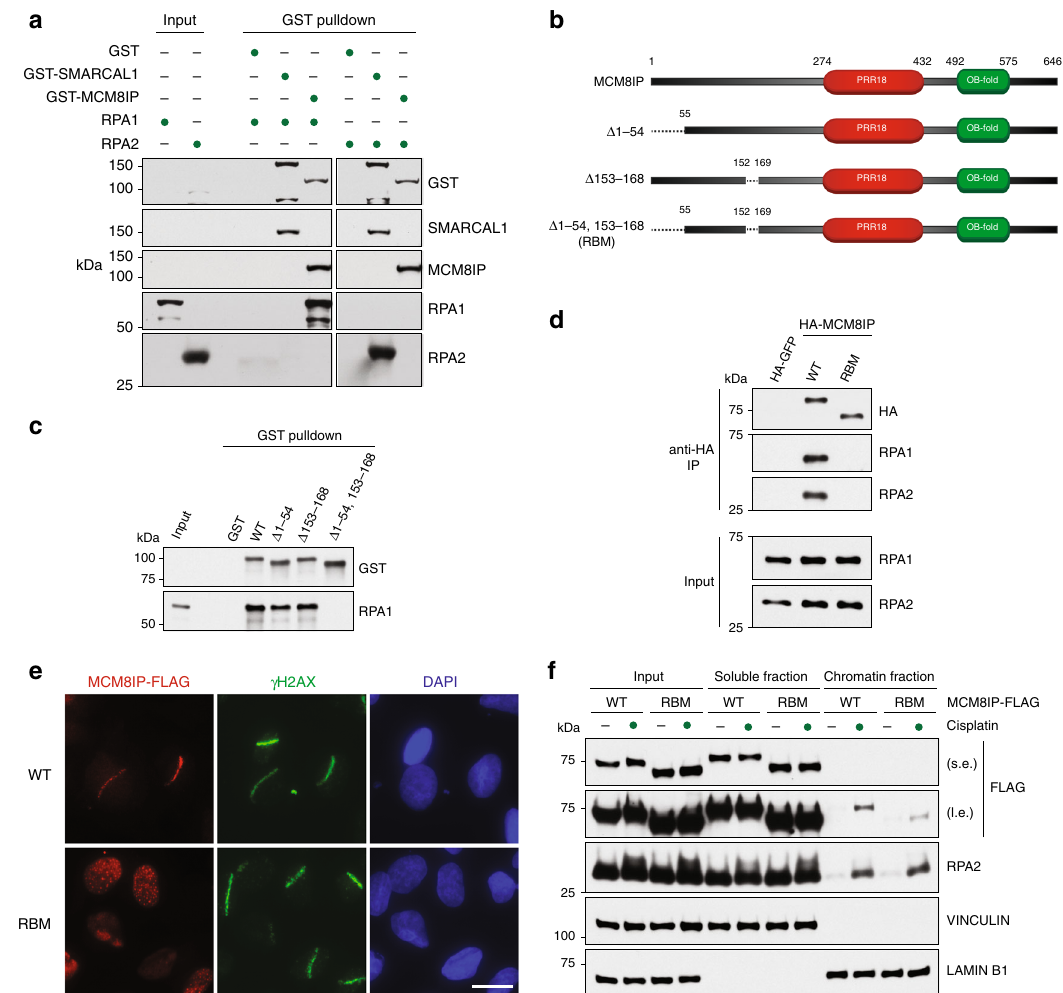
Fig. 2 Characterization of the interaction between MCM8IP and RPA1. a Detection by western blot of RPA1 and RPA2 co-precipitated by bead-bound recombinant GST, GST-SMARCAL1, or GST-MCM8IP from bacteria. b Schematic representation of full-length MCM8IP and MCM8IP with deletions in RPA1 binding motifs. The Δ 1 – 54,153 – 168 mutant was renamed RBM. Shown in red is a region with homology to proline-rich protein 18 (PRR18). The DUF4539 domain, a predicted OB-fold, is shown in green. c Detection by western blot of RPA1 co-precipitated by bead-bound GST, GST-MCM8IP WT, or GST fused to the MCM8IP mutants presented in ( b ). d Detection by western blot of RPA1 and RPA2 co-immunoprecipitated by HA-GFP, HA-MCM8IP WT, or RBM from HEK293T cells. e Representative images of the recruitment of MCM8IP-FLAG WT or RBM to sites of UV laser microirradiation in U2OS cells. DNA damage tracts are indicated with γ H2AX staining. Scale bar = 20 µ m. f Detection by western blot of MCM8IP-FLAG (short exposure, s.e.; long exposure, l.e.) and RPA2 following subcellular fractionation of lysates from HCT116 MCM8IP KO cells reconstituted with MCM8IP-FLAG WT or RBM. Cells were treated with 10 µ M cisplatin for 24 h or left untreated prior to lysis. Vinculin and Lamin B1 are shown as loading and fractionation